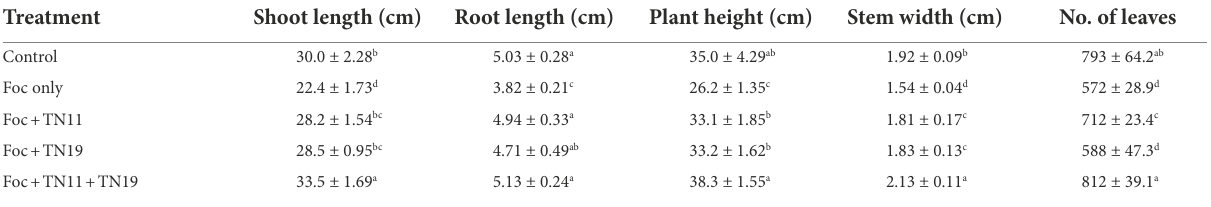
TABLE 1 Shoot length, root length, plant height, stem width, and the number of leaves of chickpea plants under unprimed control, Foc challenged, Foc challenged + TN11 primed, Foc challenged + TN19 primed, and Foc challenged + TN11 + TN19 primed,